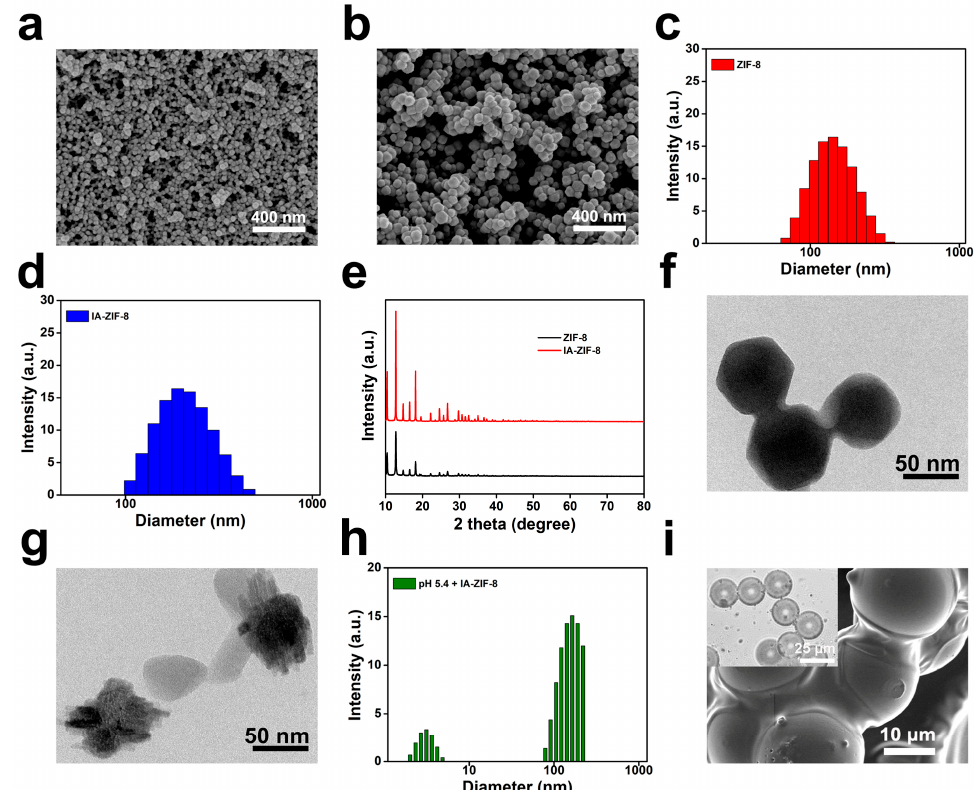
Figure 1. Physical characterizations of nanoparticles and composites. ( a , b ) Scanning electron mi- croscopy (SEM) image of zeolitic imidazolate framework-8 (ZIF-8) and IA-ZIF-8. ( c , d ) Size distribu- tion of ZIF-8 and IA-ZIF-8. ( e ) X-ray diffraction (XRD) patterns of ZIF-8 and IA-ZIF-8. ( f , g ) Transmis- sion electron microscope (TEM) image of IA-ZIF-8 in different buffers of pH 7.4 ( f ) and pH 5.4 ( g ). ( h ) Size distribution of IA-ZIF-8 in buffer of pH 5.4. ( i ) Microscopic image (scale bar: 25 µ m) and SEM image (scale bar: 10 µ m) of IA-ZIF-8@HMs.